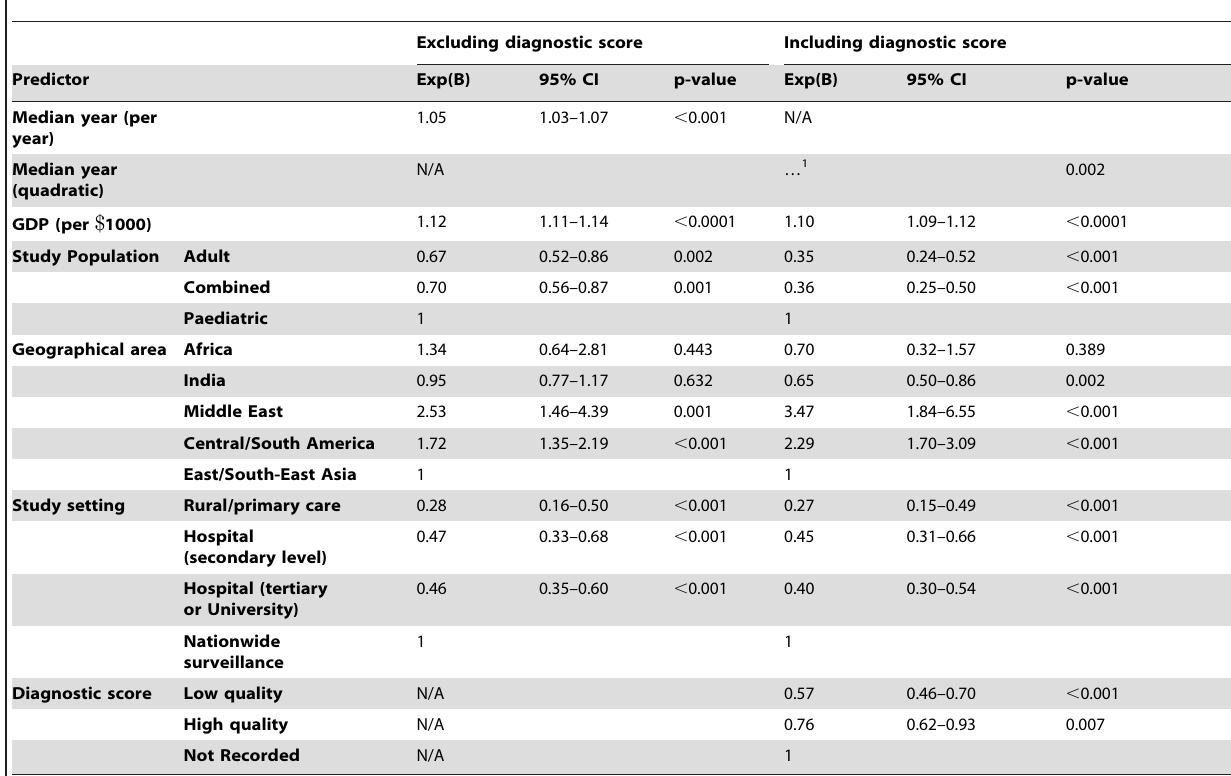
Table 4. Results of primary analysis of predictors of PCP via logistic